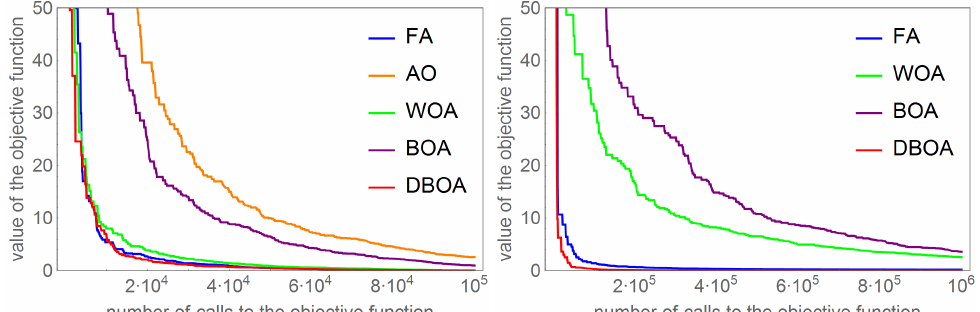
Figure 4. Comparison of the value of the objective function depending on the number of calls to the objective function for detecting one object ( left figure) and detecting two objects ( right figure).